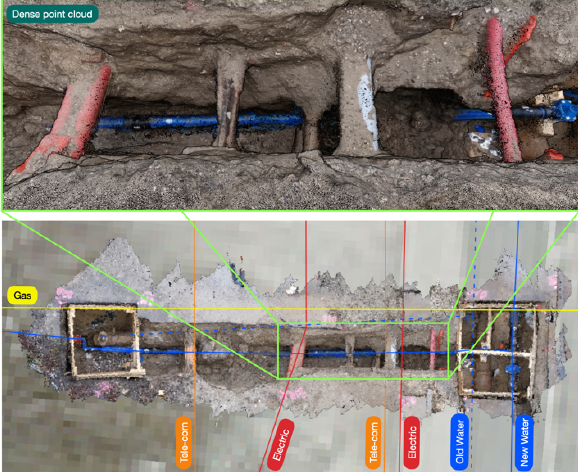
Figure 3. Common subsurface utility data collection techniques and its primary and processed data forms. Figure 4. Comparison between existing GIS utility records and as-is excavation hole point cloud seen from above (bottom) and a zoomed in 3D view of a section of the point cloud